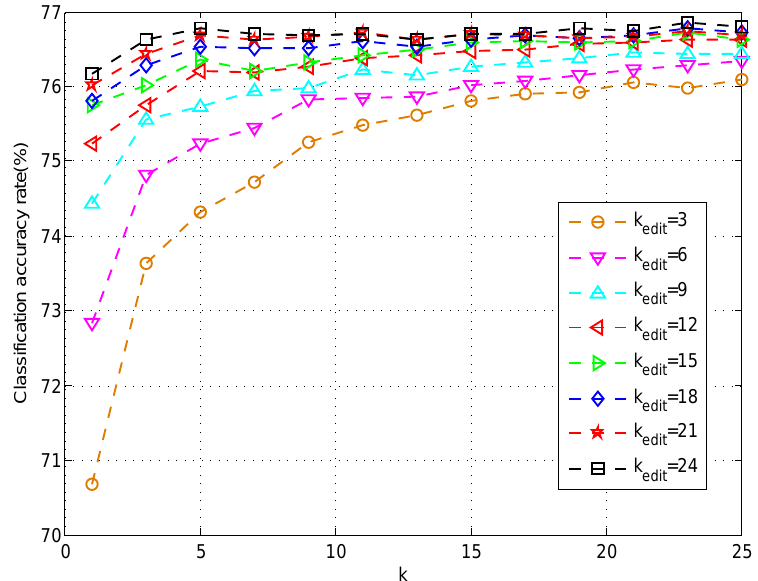
Figure 4. Classification results of the EE k NN classifier for different values of k edit and k